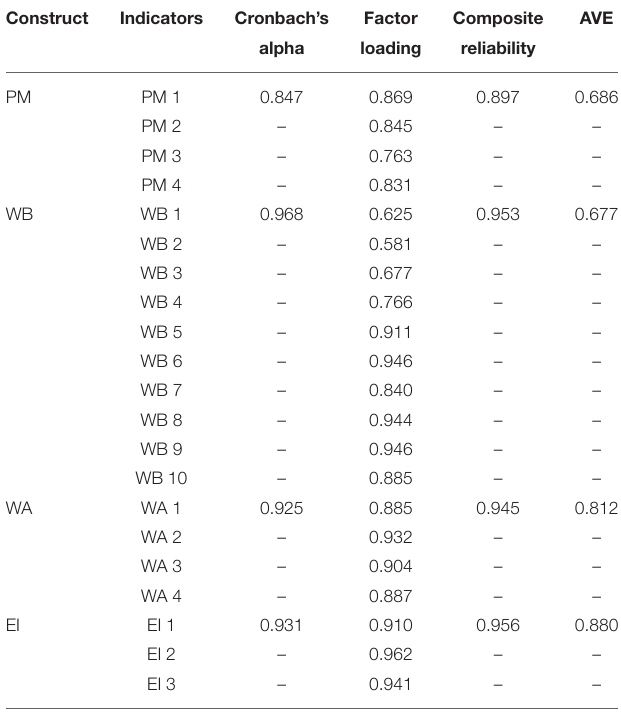
TABLE 4 | Reliability and AVE of the outer